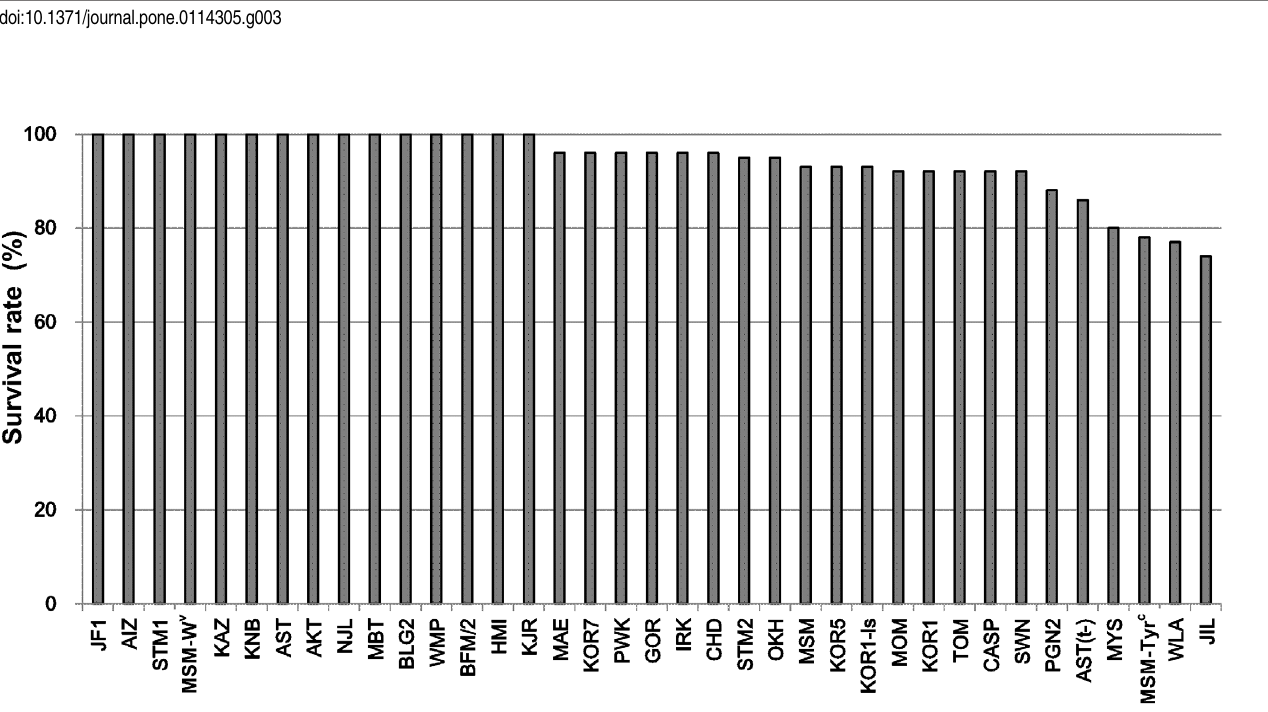
Figure 4. Survival rates of 2-cell embryos after vitrification by HOV and warming. The detailed data set is available in Table S6.